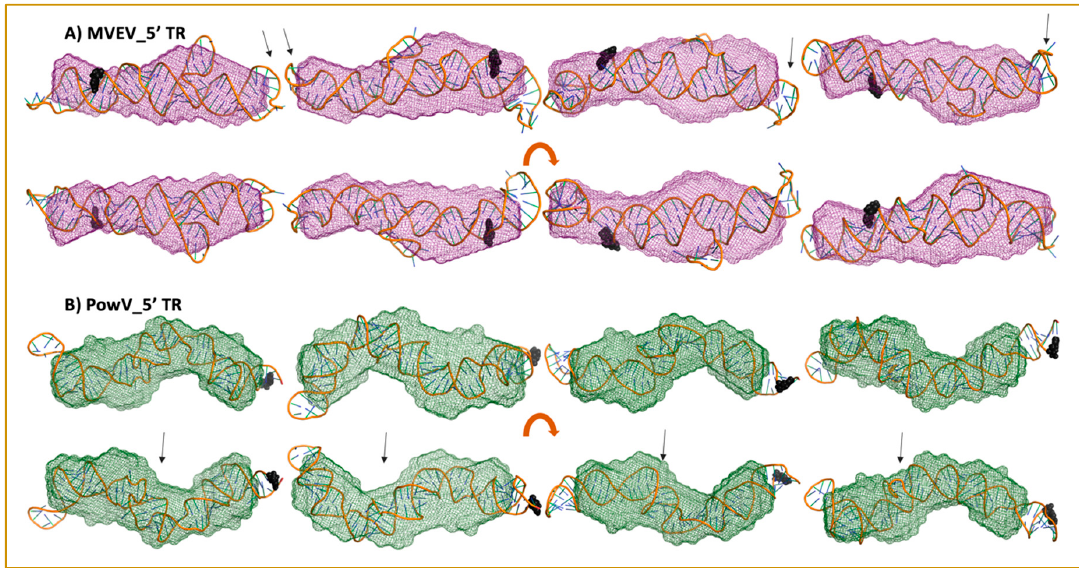
Figure 6. High-resolution structures calculated using MC-SYM overlaid with low-resolution SAXS models. A) MVEV 5TR and B) PowV 5TR. Bottom panels in both cases represent a 180 o rotation along the x-axis represented in the top panels. Black spheres represent a 5’ terminal region on each construct. The arrows represent stem-loop I (SLI) location in 5’ TRs.